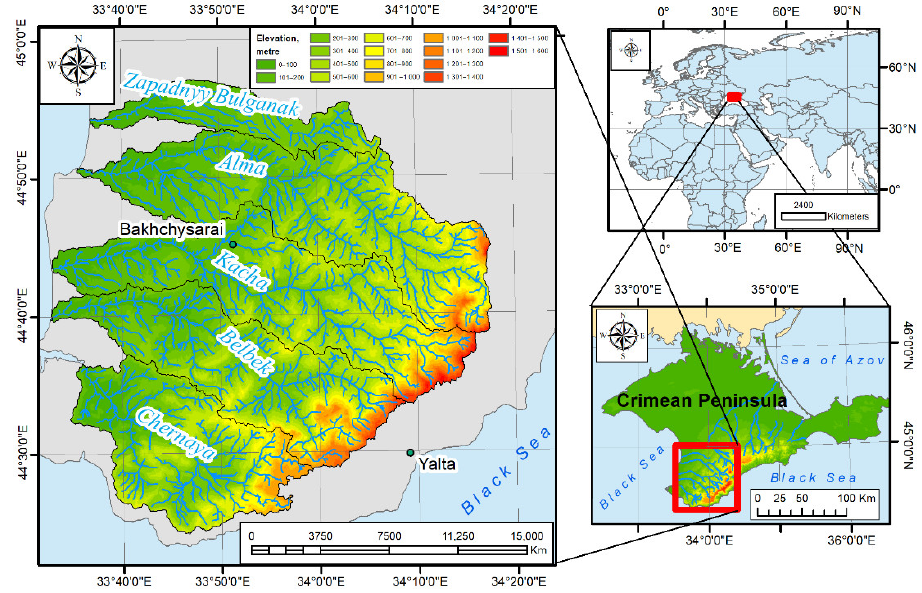
Figure 1. Geographical location of the research area.